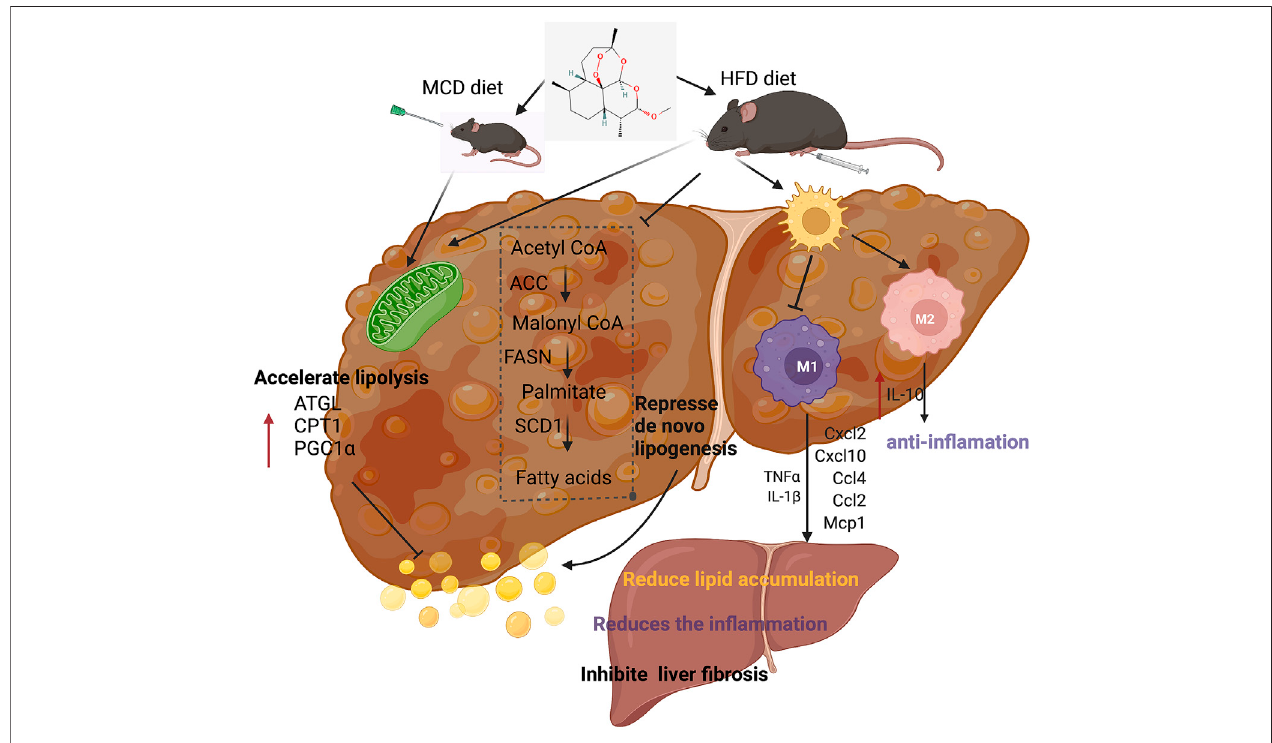
FIGURE 8 | Summary fi gure showing that the presumable molecular mechanism of artemether ameliorates non-alcoholic steatohepatitis.